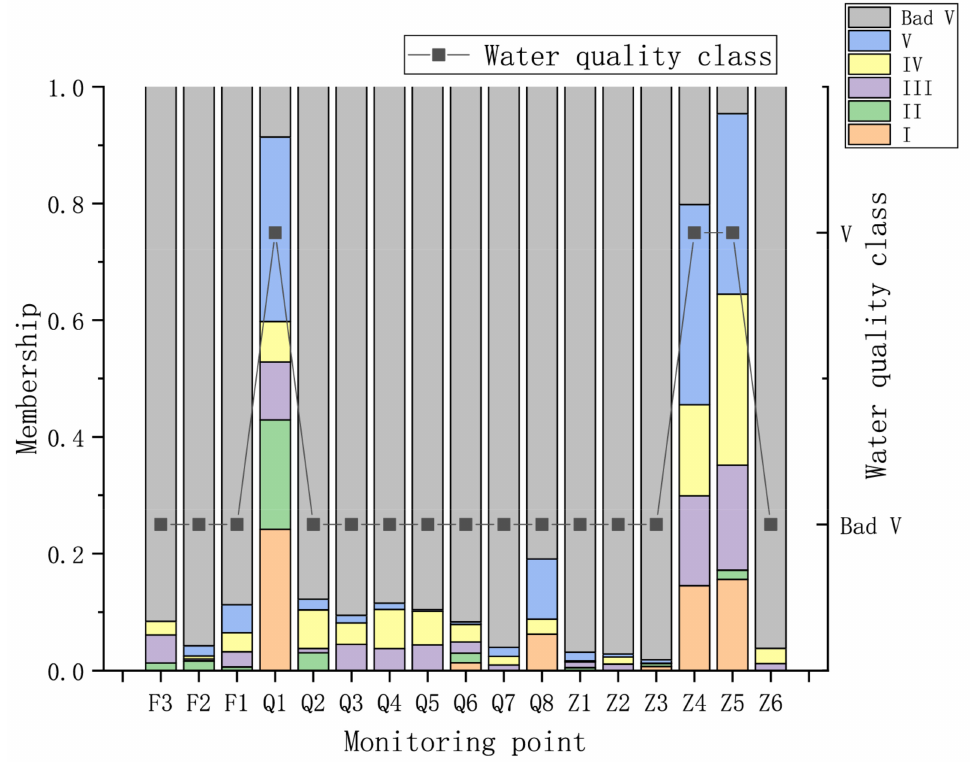
Figure 6. Results of the fuzzy comprehensive